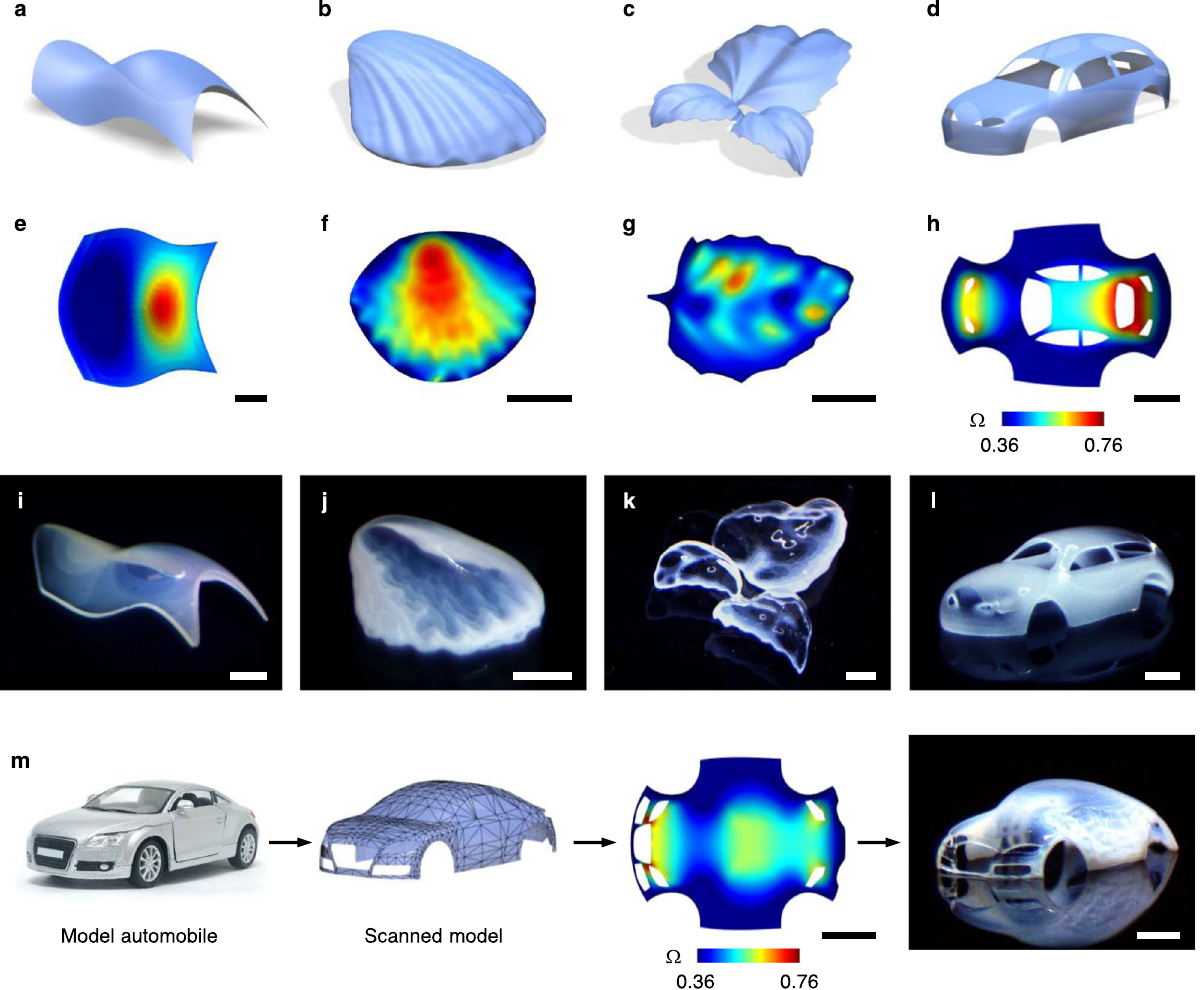
Fig. 2 Growth-induced 3D shaping. a – d Target 3D shapes: 3D shape de fi ned by a height function ( a ), sea shell ( b ), leaves ( c ), and automobile with open windows ( d ). e – h 2D growth Ω for the target shapes in a – d . i – l Experimentally printed structures using Ω in e – h . We printed three leaves with the same shape but different sizes in k . m 3D scanning and printing of a model automobile. Scale bars: 5 mm in e – h ; 3 mm in i ; 2 mm in j ; 5 mm in k ; 2 mm in l ; 5 mm (left) and 2 mm (right) in m